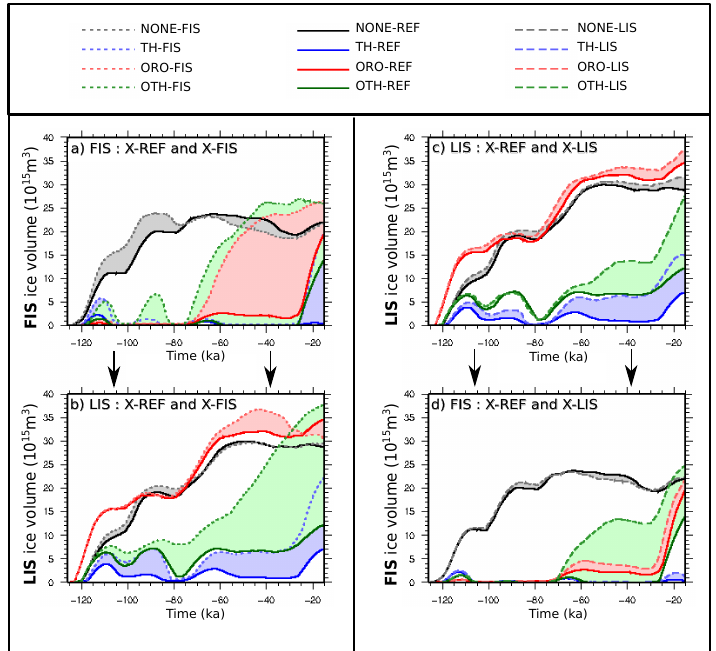
Fig. 7. The left part of the figure shows the evolution of Fennoscandian ice volume (a) for the reference experiments (solid lines, black when the waves are off, blue for the thermal parameterization, red for the orographic parameterization, and green when the two effects are on) and for the experiments with a smaller σ FIS (plotted line, same color code). (b) shows the Laurentide ice volume for the same experiments. The 0 right part of the figure shows the evolution of the Laurentide ice volume (c) for the reference experiments (solid lines) and for the ones with smaller σ LIS (dotted lines), then the Fennoscandian ice volume (d) for the same experiments. For all panels, the evolution of ice volume is 0 shown for the all